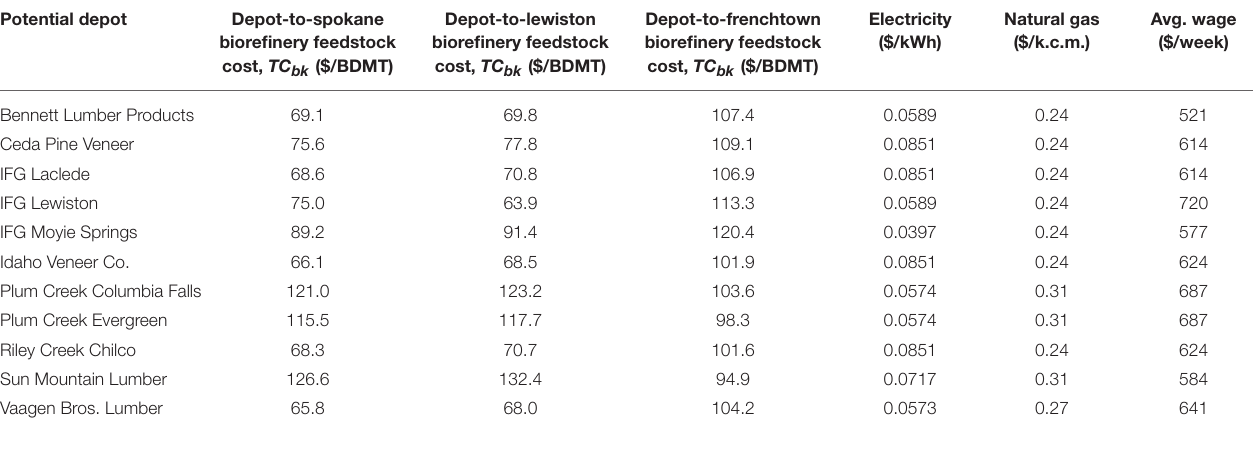
TABLE 4 | Location-specific criterion values for each potential depot.